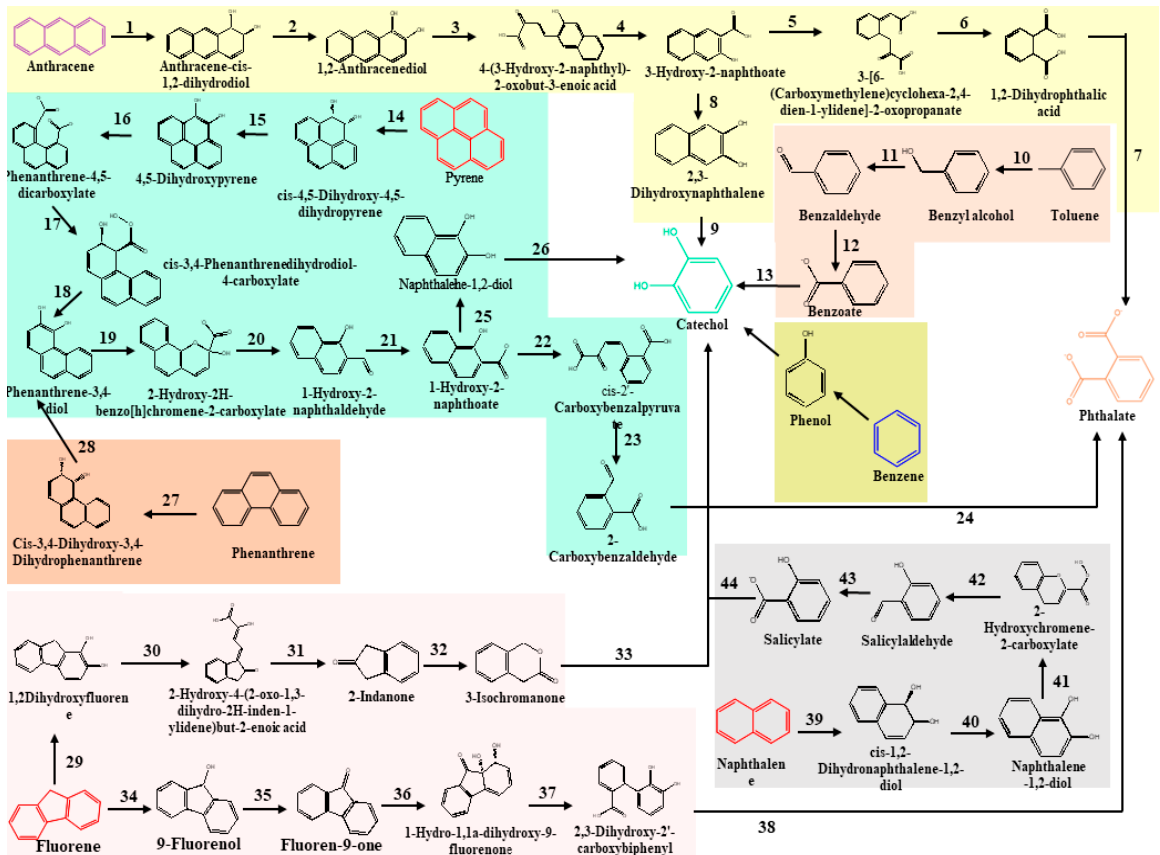
Figure 1. Pathways for degradation of anthracene, pyrene, phenanthrene, fluorene, toluene, naph- thalene, and benzene until the formation of intermediate product catechol and phthalate. The en- zymes involved in the reactions are 1. naphthalene 1,2-dioxygenase; 2. cis-1,2-dihydro-1,2-dihy- droxynaphthalene dehydrogenase; 3. anthra-cene-1,2-diol 1,2-dioxygenase; 4. Dioxygenase; 5. 3-hy- droxy-2-naphthoate 2,3-dioxygenase; 6. Oxidoreductases; 7. Oxidoreductases; 8. 3-hydroxy-2-naph- thoate 2,3-dioxygenase; 9. chloroben-zene dihydrodiol dehydrogenase 10. toluene monooxygenase system protein A; 11. aryl-alcohol dehydrogenase; 12. benzaldehyde dehydrogenase; 13. dihy- droxycyclohexadiene carboxylate de-hydrogenase; 14. pyrene dioxygenase; 15. dibenzothiophene dihydrodiol dehydrogenase; 16. 4,5-dihydroxypyrene dioxygenase; 17. phenanthrene-4,5-dicarbox- ylate decarboxylase; 18. phe-nanthrene-4-carboxylate dioxygenase; 19. extradiol dioxygenase; 20. hydratase-aldolase; 21. al-dehyde dehydrogenase; 22. 1-hydroxy-2-naphthoate dioxygenase; 23. 4- (2-carboxyphenyl)-2-oxobut-3-enoate aldolase; 24. 2-formylbenzoate dehydrogenase; 25. salicy-late hydroxylase; 26. Nah C; 27. PAH dioxygenase; 28. cis-3,4-dihydrophenanthrene-3,4-diol de-hydro- genase; 29. Hydroxylases; 30. 1,2-dihydroxyfluorene 1,1a-dioxygenase; 31. Alcohol dehy-drogenase; 32. 2-indanone monooxygenase; 33. 34. naphthalene 1,2-dioxygenase; 35. fluoren-9-ol dehydrogen- ase; 36. dibenzofuran dioxygenase; 37. 1,1a-dihydroxy-1-hydro-9-fluorenone dehy-drogenase; 38. 2-